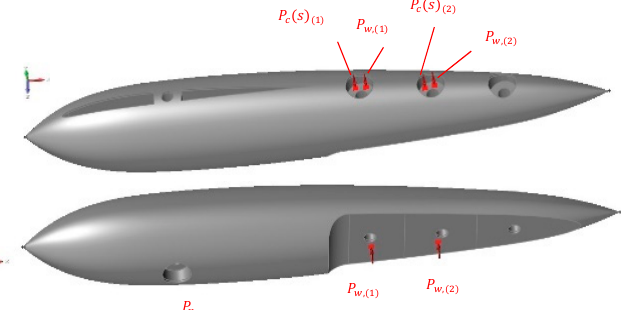
Figure A4. Rudder Upward (s) load case, constraints are hidden for representation purpose.